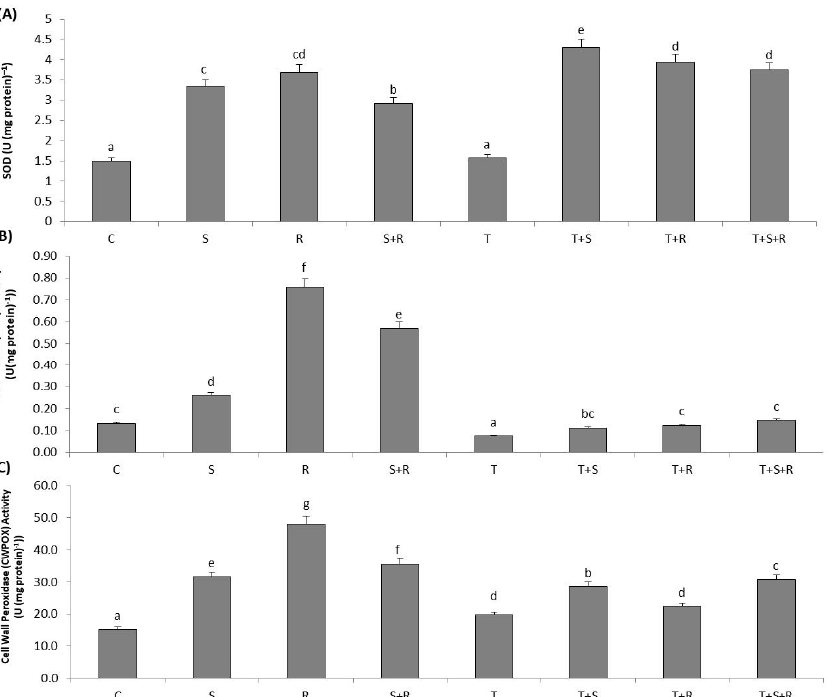
Figure 8. The effect of T. citrinoviride on SOD ( A ), POX ( B ) and CWPOX ( C ) activities in the leaves of strawberry plants which were subjected to abiotic stress (40 mM NaCl) and biotic stress (R. solani) either separately or in combination. Different letters indicates significant differences between treatments ( p < 0.05). C, control; S, NaCl-treated; R, R. solani -infected ; S + R, Salt stress + R. solani; T, T. citrinoviride- treated; T + S, T. citrinoviride + NaCl; T + R, T. citrinoviride + R. solani ; T + S + R, T. citrinoviride + NaCl + R. solani.